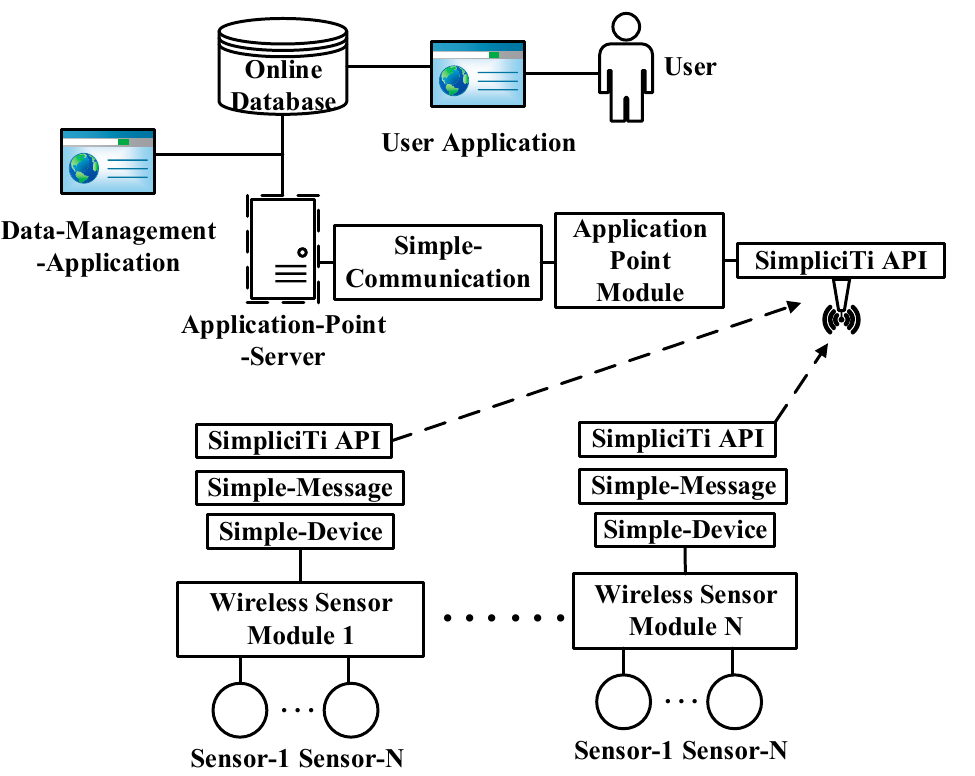
Figure 2. Block diagram of system software framework. API: Application Programming Interface.